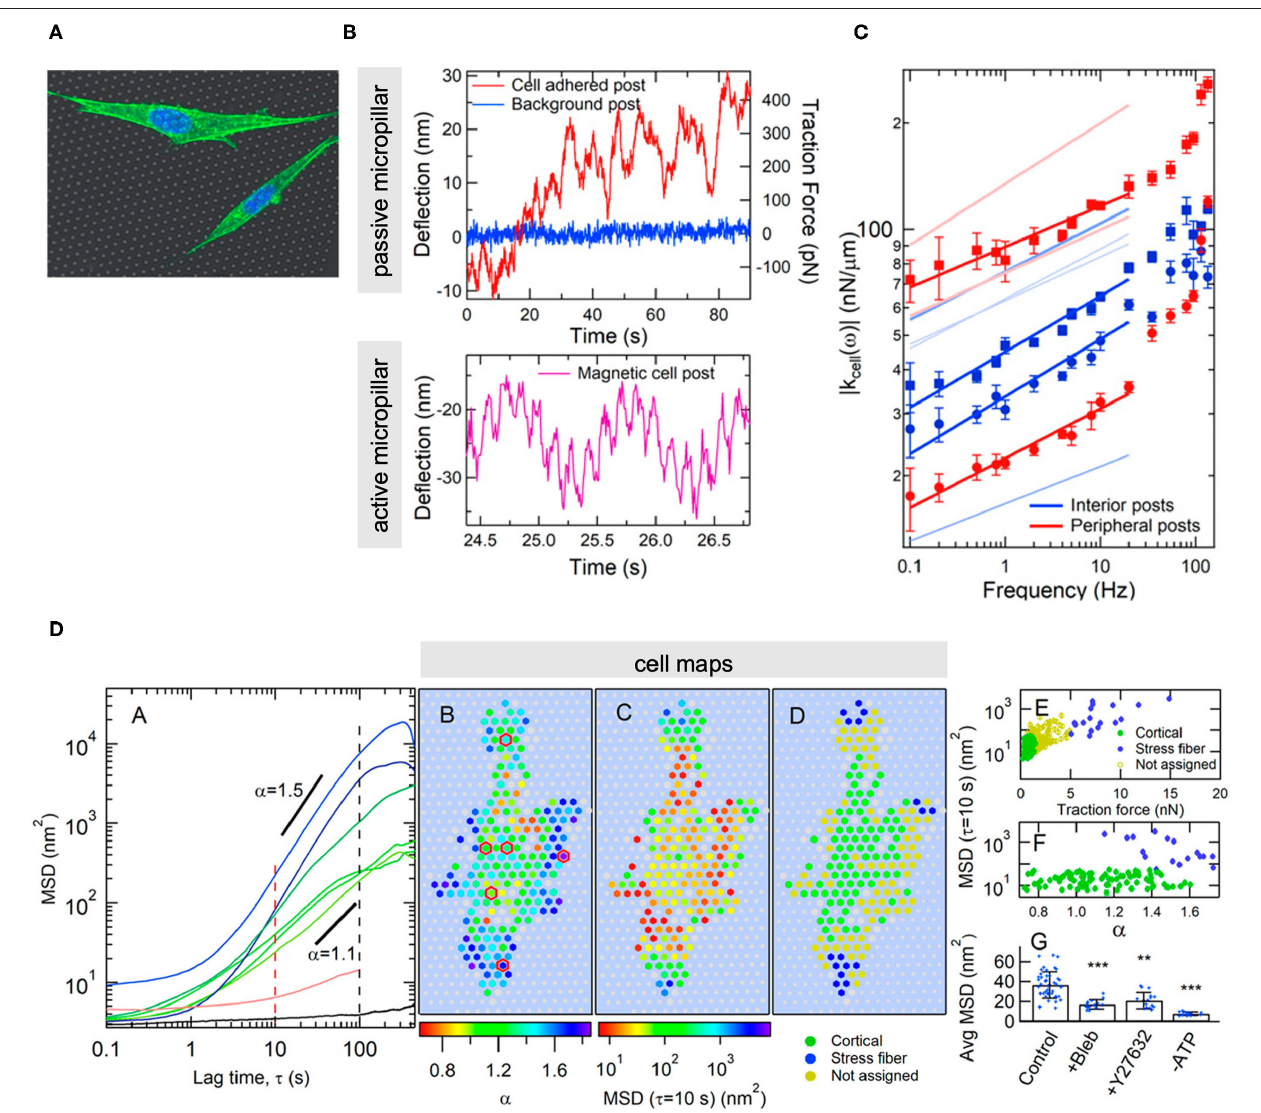
FIGURE 8 | Example of combining TFM and actuator arrays to obtain microrheological data and map cell-generated fluctuations at the basal membrane of adherent cells. (A) Image of cells on the microstructured substrate. (B) Typical experimental output of a non-actuated (upper graph) and an actuated micropillar driven by a double-sinusoidal magnetic field at 1 and 7Hz (lower graph). (C) Dynamic stiffness as a function of frequency for micropillars situated in the central (blue) and the peripheral (red) regions of the cell, exhibiting different power-law dependences. (D) From left to right: mean square displacements of passive micropillar deflections and MSD exponents that differ in the central (cortical) and the peripheral (dense in stress fibers) regions and show superdifusive behavior. Spatial distributions of MSD exponents, mean square displacements and traction forces across the cell and according to the regions rich in actin cortex and stress fibers. MSD values and traction forces according to type of micropillar (level of significance: ** p < 0.01; *** p < 0.001). The effect of cytoskeletal disrupting agents on the cellular fluctuations reveal that the structure involved is the actomyosin network. (Figures reproduced from Shi et al.,